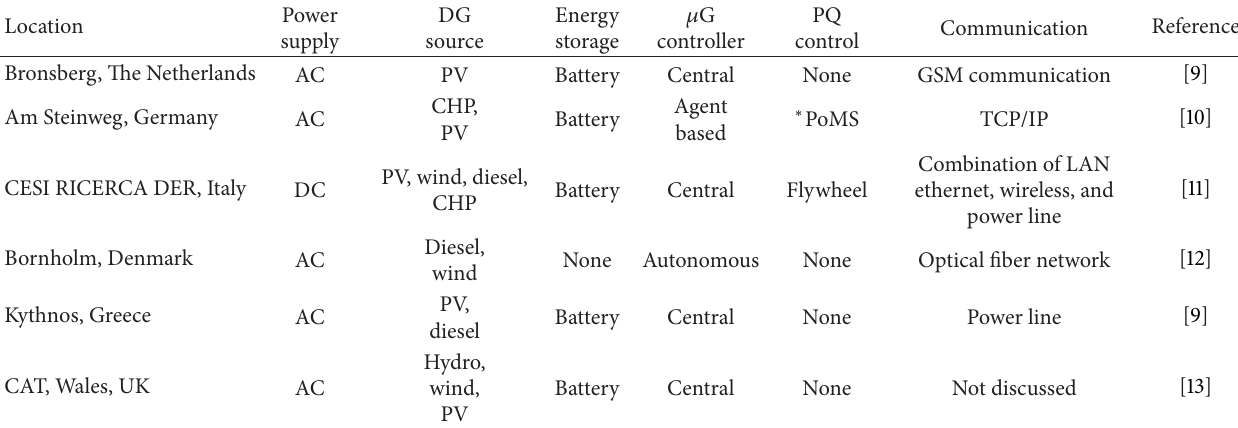
Table 4: Existing examples of 𝜇 Gs in